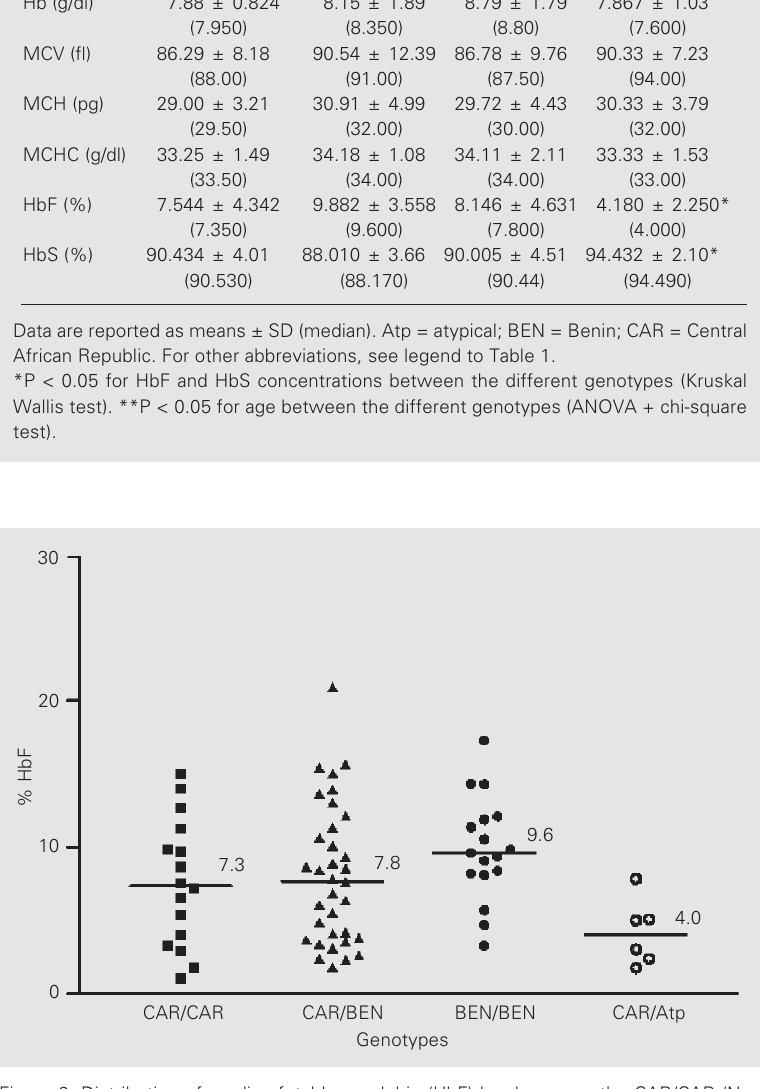
Figure 2. Distribution of median fetal hemoglobin (HbF) levels among the CAR/CAR (N = 17), CAR/BEN (N = 37), BEN/BEN (N = 17) and CAR/Atp (N = 6) genotypes in sickle cell disease patients from Salvador, Bahia, Brazil. For abbreviations, see legend to